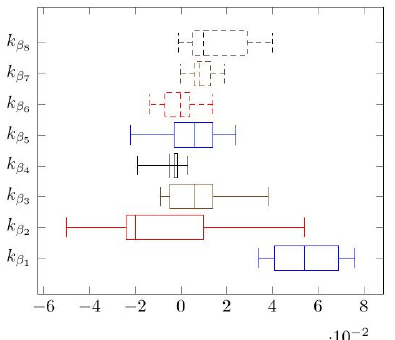
Figure 4. Box plot of the system parameters from the OLS Identification.